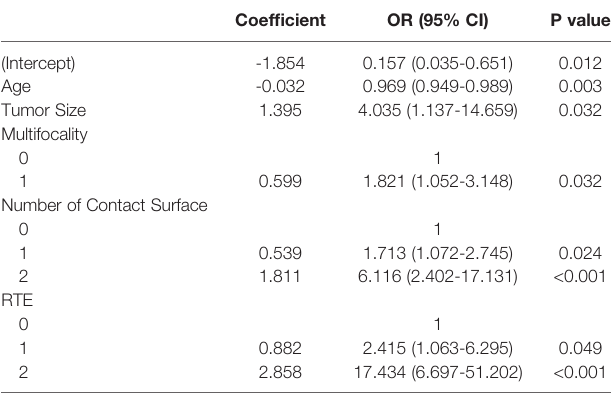
TABLE 2 | Prediction factors and regression coef fi cients of the prediction